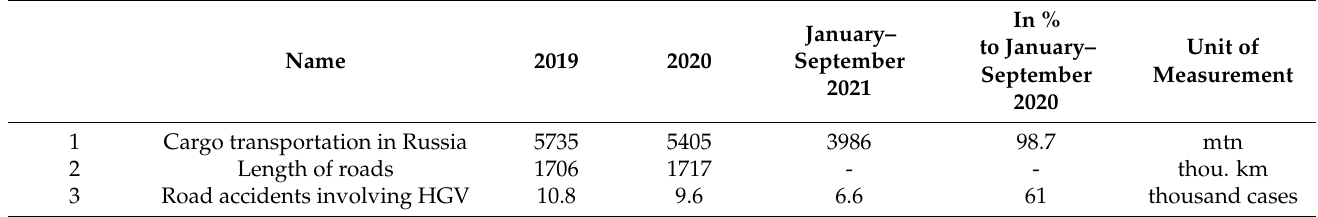
Table 1. Statistical data on freight transportation by road in the Russian Federation 1